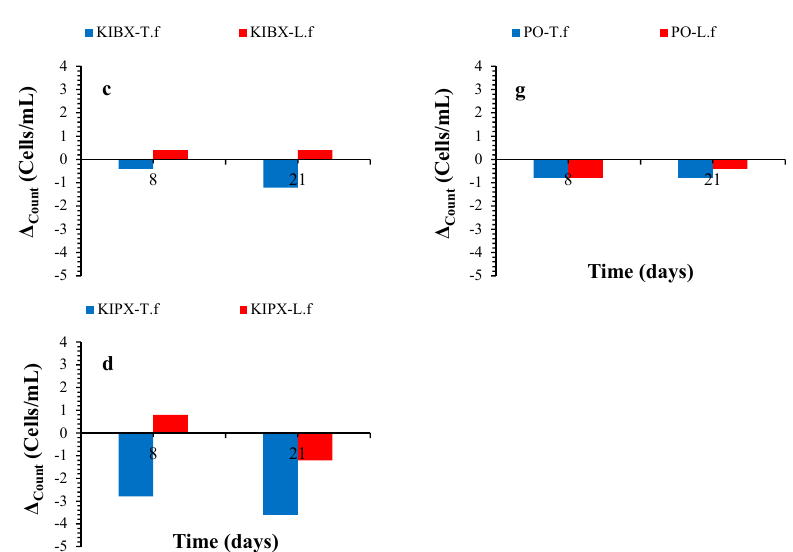
Figure 4 . Effects of various flotation reagents on bacterial population during L. ferrooxidans and T. ferrooxidans activities.